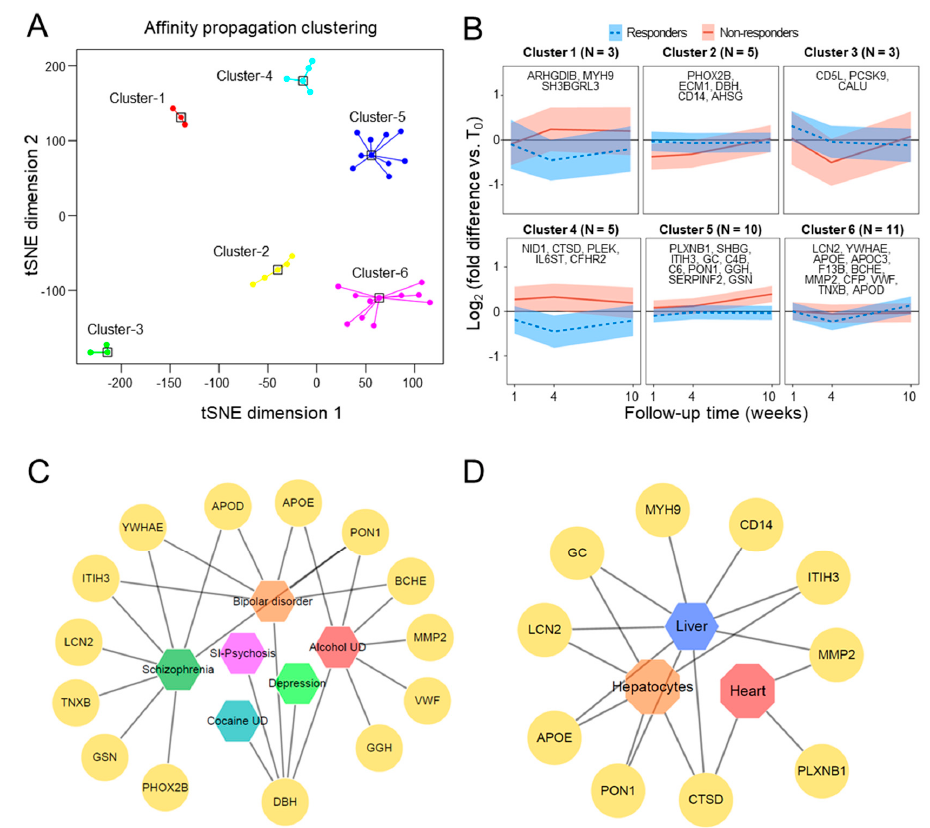
Figure 2. Affinity propagation clustering, profile analysis, and public database search of the 37 proteins found to differ significantly in the response/time interaction of linear mixed model (LMM). ( A )Identification of seven protein clusters by t-SNE-based affinity propagation clustering. ( B ) Change over time in protein amount in responders and non-responders. ( C ) Association of 14 proteins found on PsyGeNet with psychiatric diseases. ( D ) Association of ten proteins found in the DrugMatrix category of Enrichr with responses of rat tissues and cells to selective serotonin reuptake inhibitors